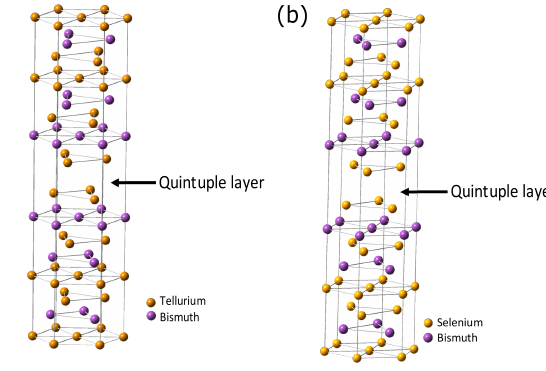
Figure 2: (a) Crystal structure of Bi 2 Te 3 (b) Crystal structure of Bi 2 Se 3